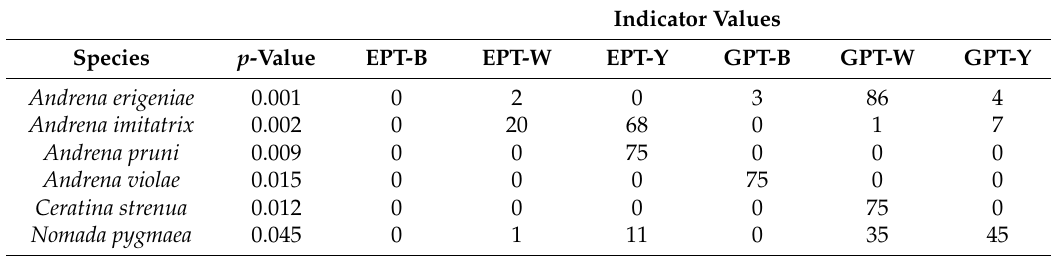
Table 4. Indicator values for species significantly associated with a particular pan trap color/elevation based on indicator species analysis of bees collected in oak-hickory forest in Hancock County, IL, USA, April–September 2011. EPT-B = blue elevated pan trap, EPT-W = white elevated pan trap, EPT-Y = yellow elevated pan trap, GPT-B = blue ground-level pan trap, GPT-W = white ground-level pan trap, GPT-Y = yellow ground-level pan trap. Indicator Values Species p -Value EPT-B EPT-W EPT-Y GPT-B GPT-W GPT-Y Andrena erigeniae 0.001 0 2 0 4